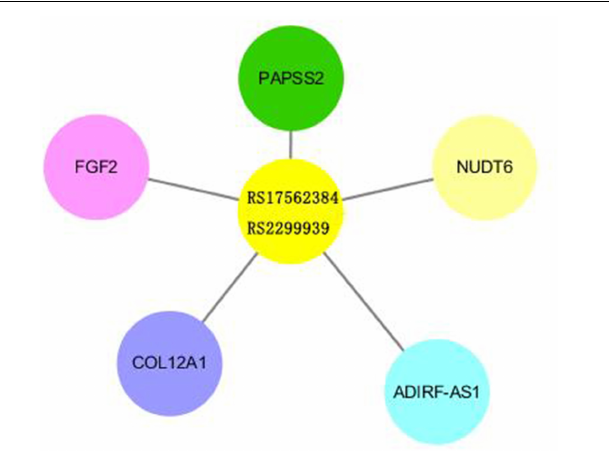
FIGURE 4 | Results of eQTL analysis of rs2299939/rs17562384. The length of the bars revealed the relativity between SNP and Exp genes.